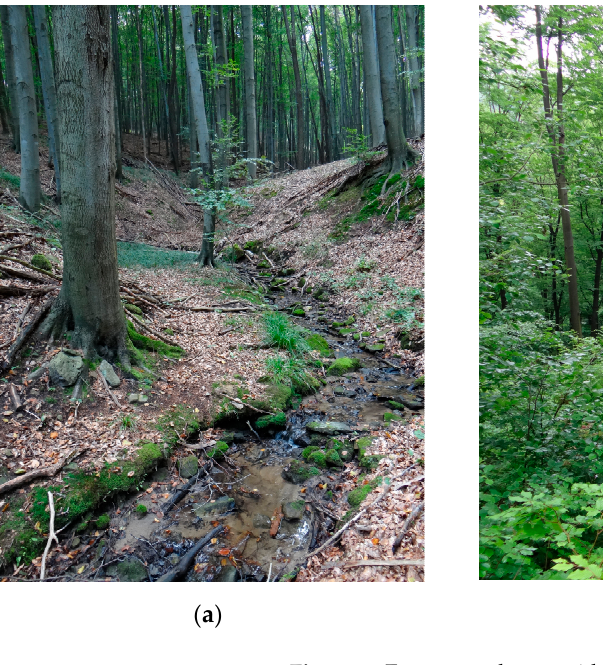
( b ) Figure 6. Floodplain forests on wider alluvium with C. heros, forest management unit 297: ( a ) forest stand with Fraxinus excelsior and Alnus glutinosa; ( b ) forest stand with vertical structure of Acer pseu- doplatanus , F. excelsior , A. glutinosa , Fagus sylvatica, and Carpinus betulus .